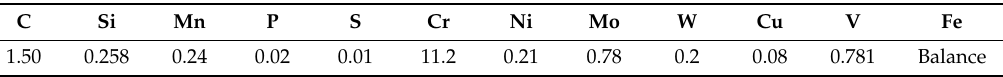
Table 1. Chemical composition of AISI D2 cold-work tool steel (in Weight